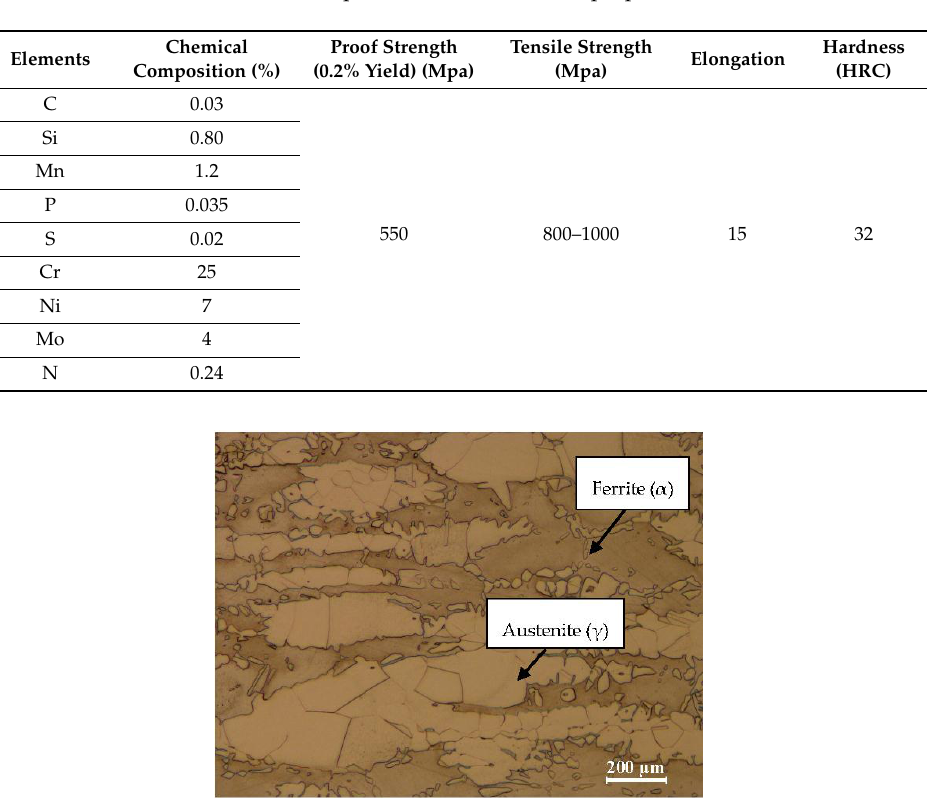
Table 1. Chemical composition and mechanical properties of S32750.